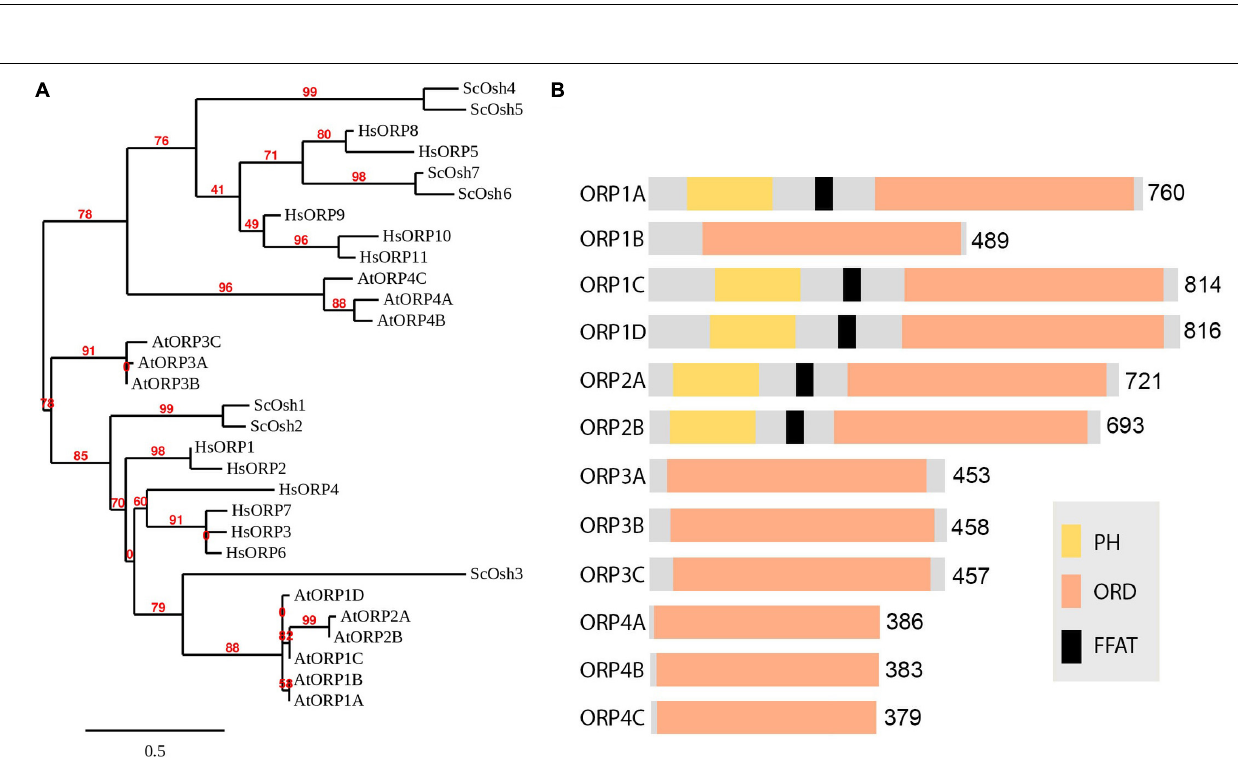
Frontiers in Plant Science |